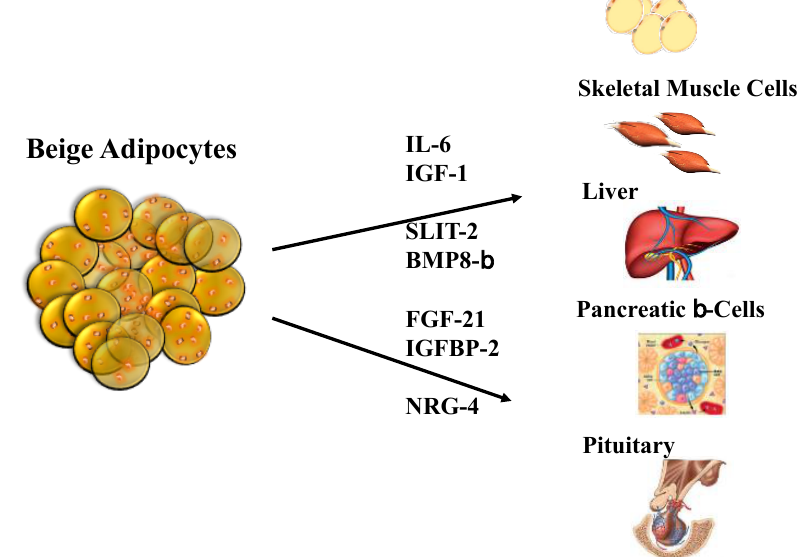
Figure 3. Adipokines secreted by beige adipocytes, which are also known as “batokines”. Beige adipocytes secrete molecules that have endocrine effects on some of the most important tissues involved in the regulation of body weight and lipid and carbohydrate metabolism. BMP8- β , bone morphogenetic protein 8b; IGF-1, insulin-like growth factor 1; IGFBP-2, insulin-like growth factor binding protein 2; IL-6, interleukin 6; NRG-4, neuregulin 4; SLIT-2, slit homolog protein 2. Adapted from Arroyave et al. [230].